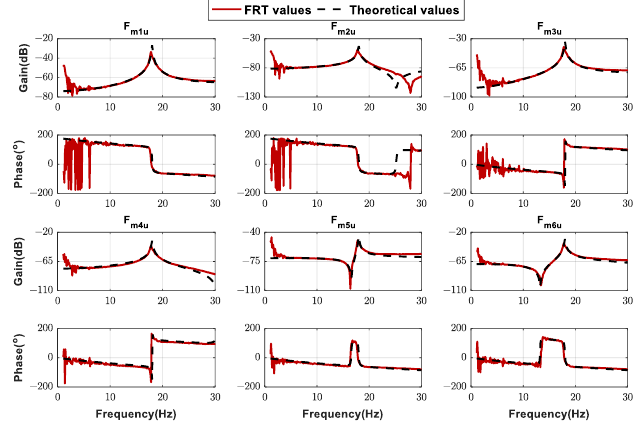
Figure 21. Comparison of FRFs between FRT values and theoretical values: F me .